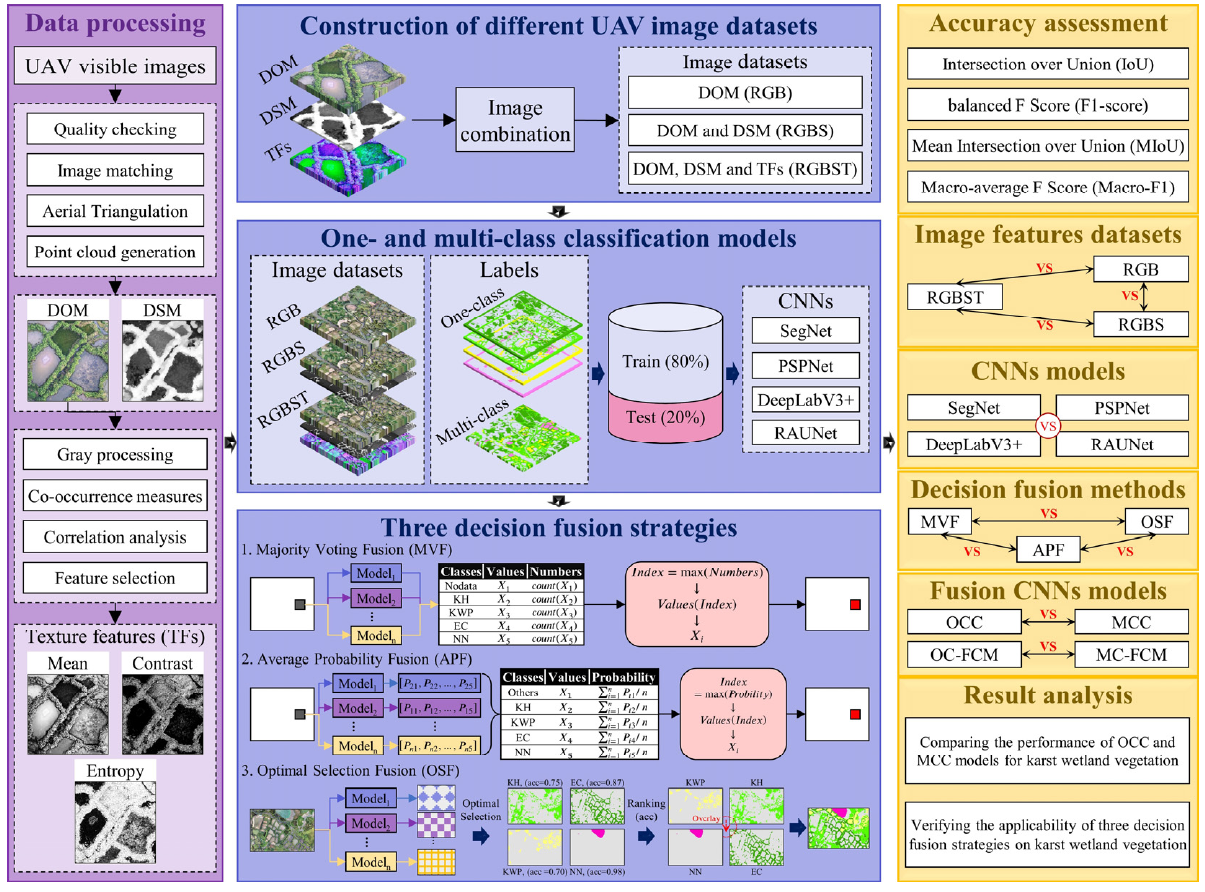
Figure 3. Technical route. It is divided into three sections from left to right. The first section on the left is the data processing of UAV images. The second section in the middle is divided into three parts: (1) Construction of image datasets; (2) training of four one- and multi-class CNN classification models. Three combination datasets of UAV images and their semantic labels were used for training of SegNet, PSPNet, DeepLabV3+, and RAUNet, respectively, and OCC and MCC models were built; (3) three decision fusion strategies, which are explained in detail in Section 2.3.3. The third section on the right is the accuracy assessment metrics and comparative analysis of classification results between different classification models.